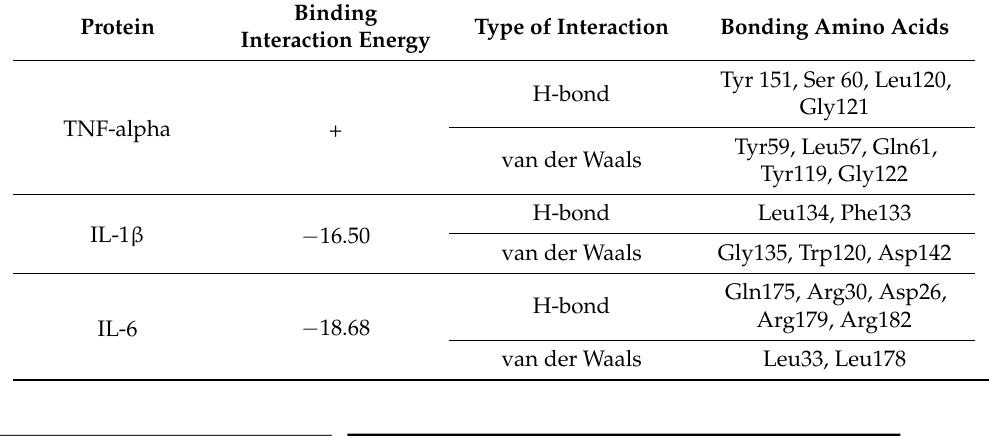
Table 5. Molecular docking of chondroitin sulfate on the active pocket of protein molecules. Protein